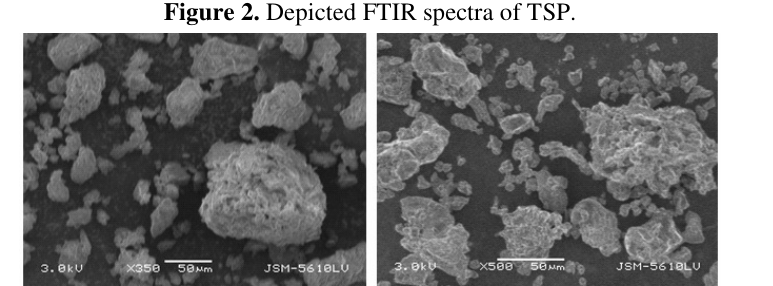
Figure 2. Depicted FTIR spectra of TSP.